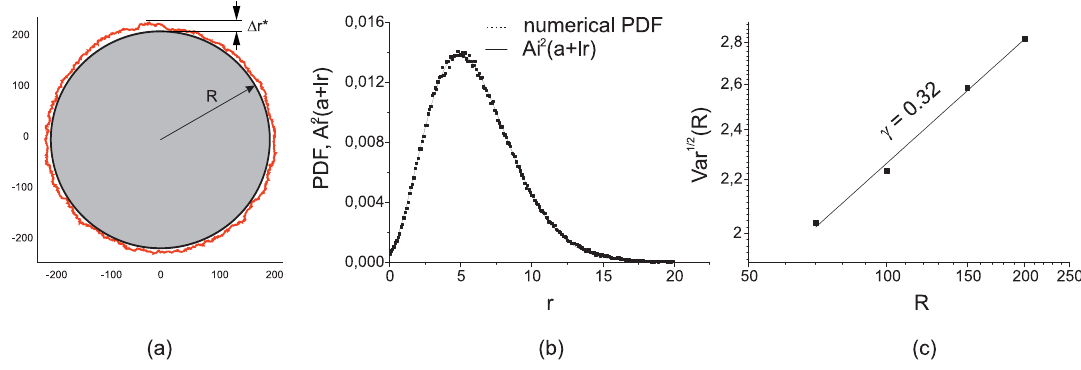
Figure 6 . (a) Distribution of the fluctuations of the inflated ring above the impenetrable disc; (b) Scaling of fluctuations as a function of the path length in log-log